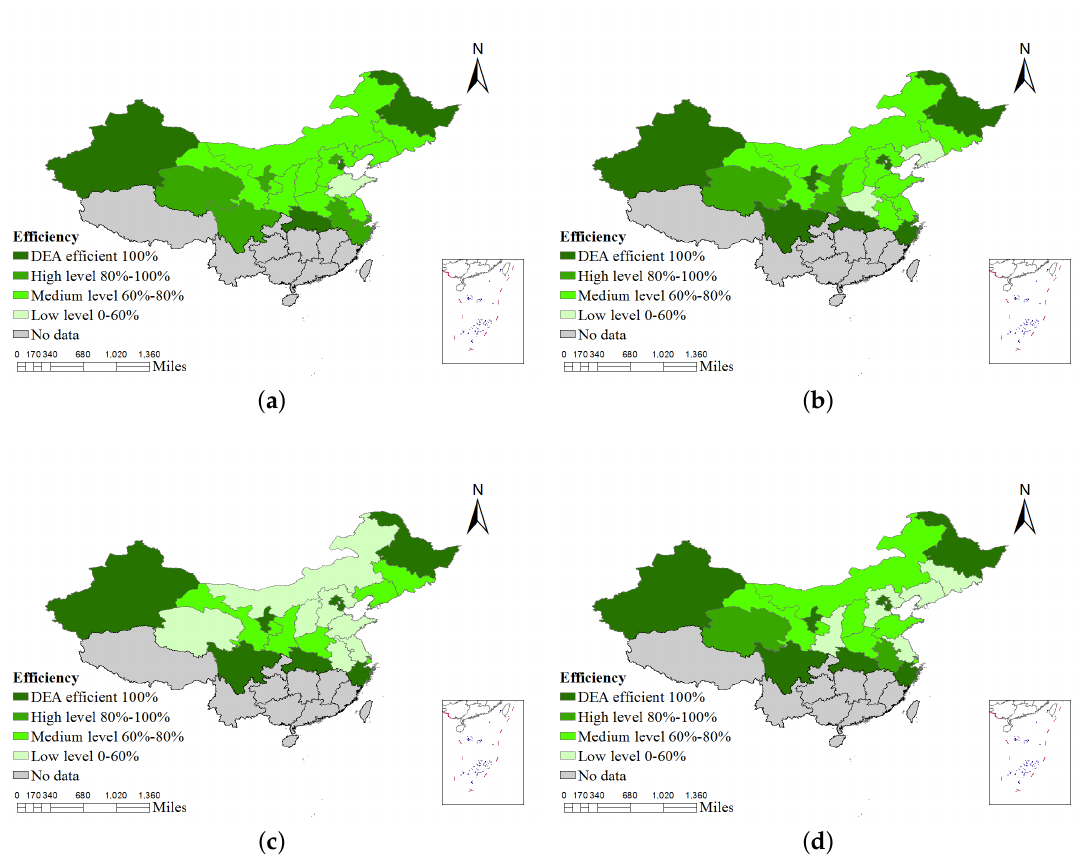
Figure 3. Spatial distribution map of OTE ( a ), fertilizer efficiency ( b ), farm manure efficiency, ( c ) and pesticide efficiency ( d ) of greenhouse